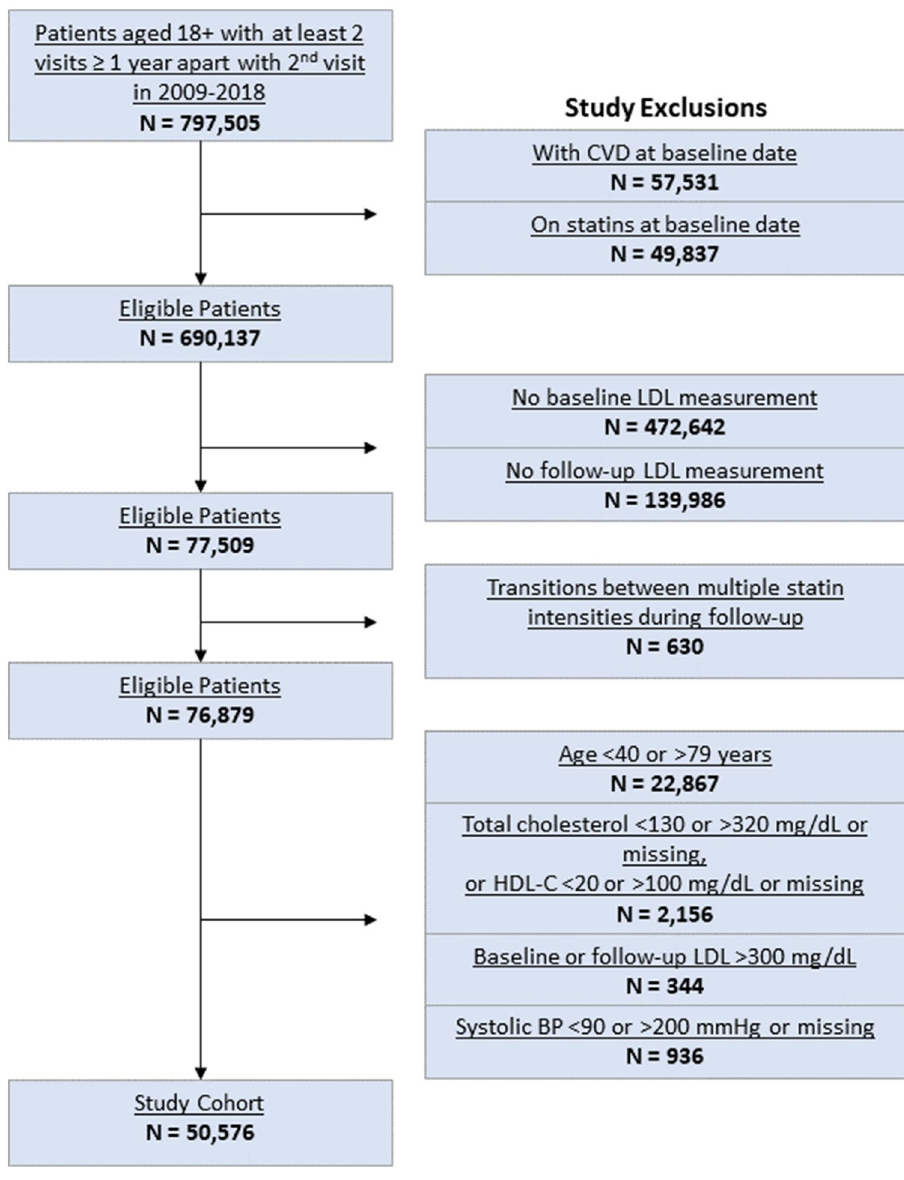
Figure 1. CONSORT cohort selection diagram. BP Blood pressure, CVD Cardiovascular disease, HDL-C High density lipoprotein cholesterol, LDL-C Low density lipoprotein